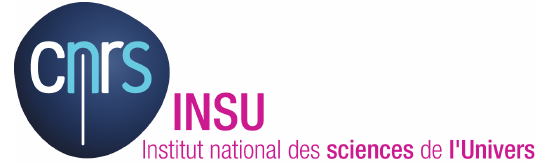
Figure 4. Comparison of tree-ring δ 18 O and ice-core δ 18 O records on Tibetan Plateau 542